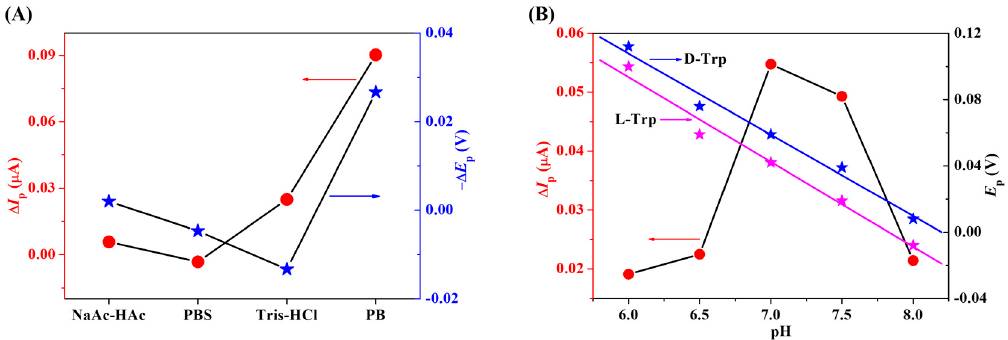
Figure 7. Influences of supporting electrolytes ( A ) and pH ( B ) on enantiorecognition efficiency of N-CDs/ β -CD/GCE toward Trp enantiomers. Errors bars represent the standard deviation for three independent measurements.